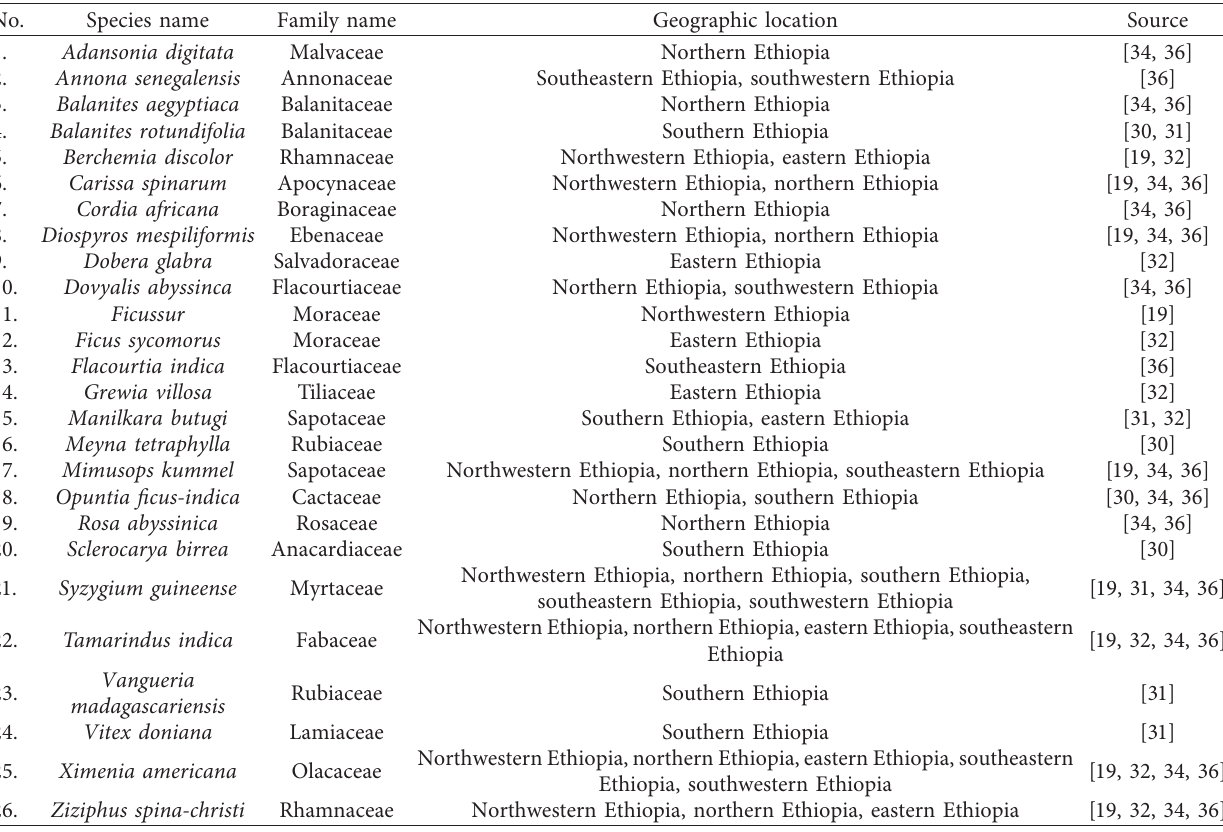
Table 2: Marketable wild edible fruit species in different geographic locations of